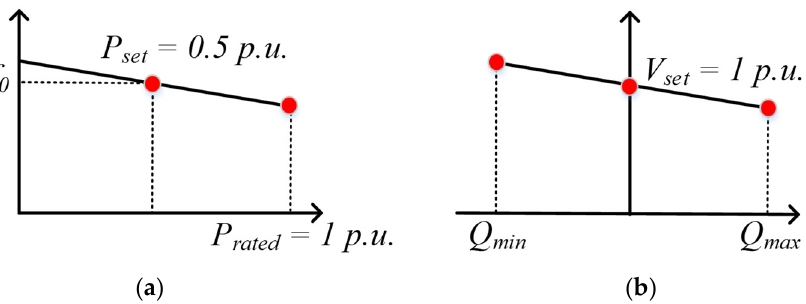
Figure 6. Droop Characteristics Plots for the Generic Control Scheme of a GFMI. ( a ) f-P droop curve. ( b ) Q-V droop curve.